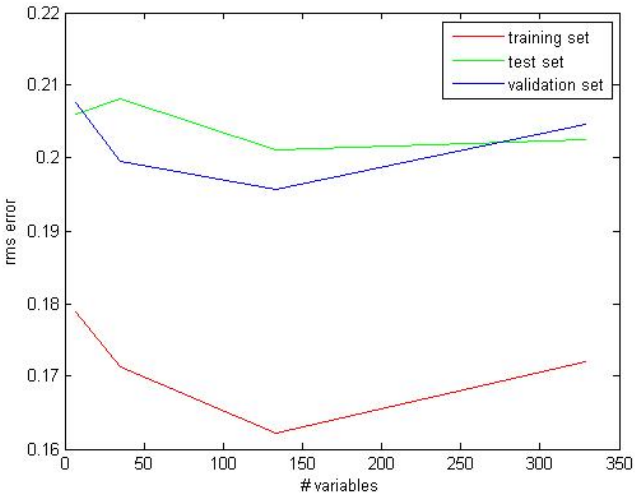
Figure 13. Root Mean Square (RMS) error, as a function of the number of variables for training, test and validation sets. The results were obtained averaging over 10 random trials.